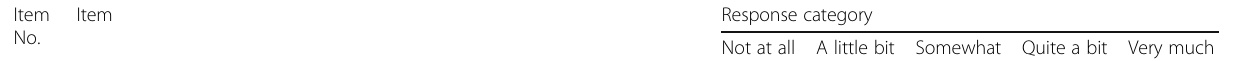
Table 1 The Functional Assessment of Cancer Therapy-EGFRI 18 (FACT-EGFRI 18) Instructions: “ Below is a list of statements that other people with your illness have said are important. Please check one box per line to indicate your response as it applies to the past 7 days. ” Item